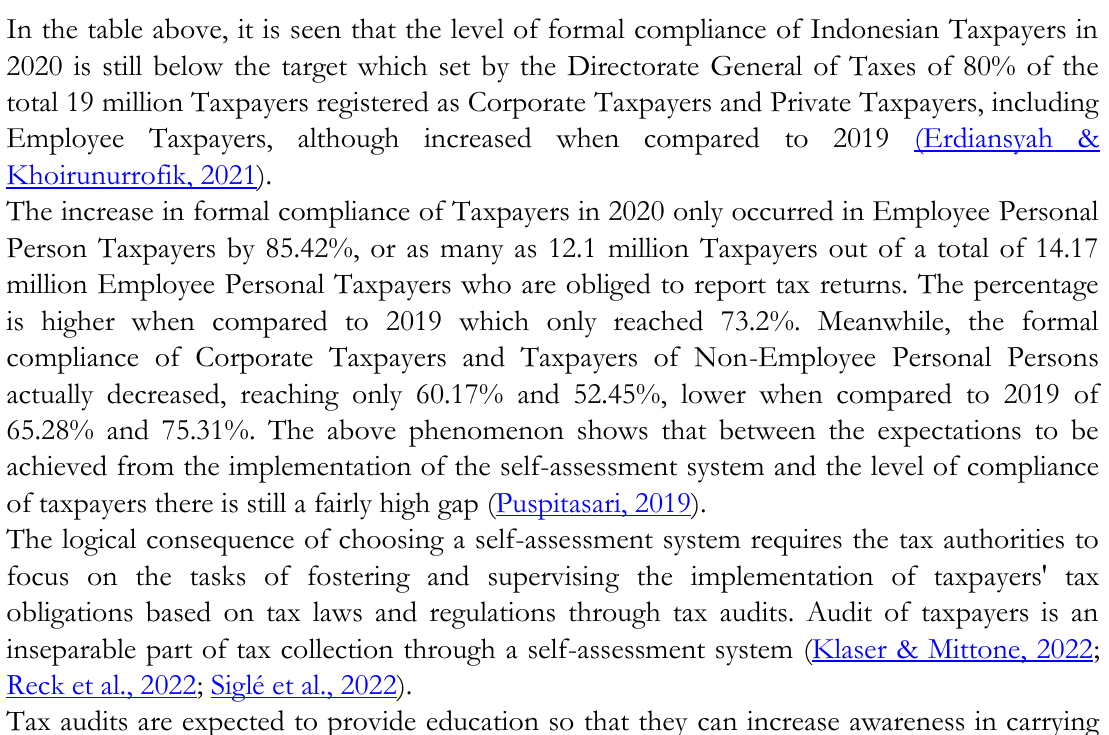
Table 2 Indonesian Tax Revenues 2016-2020